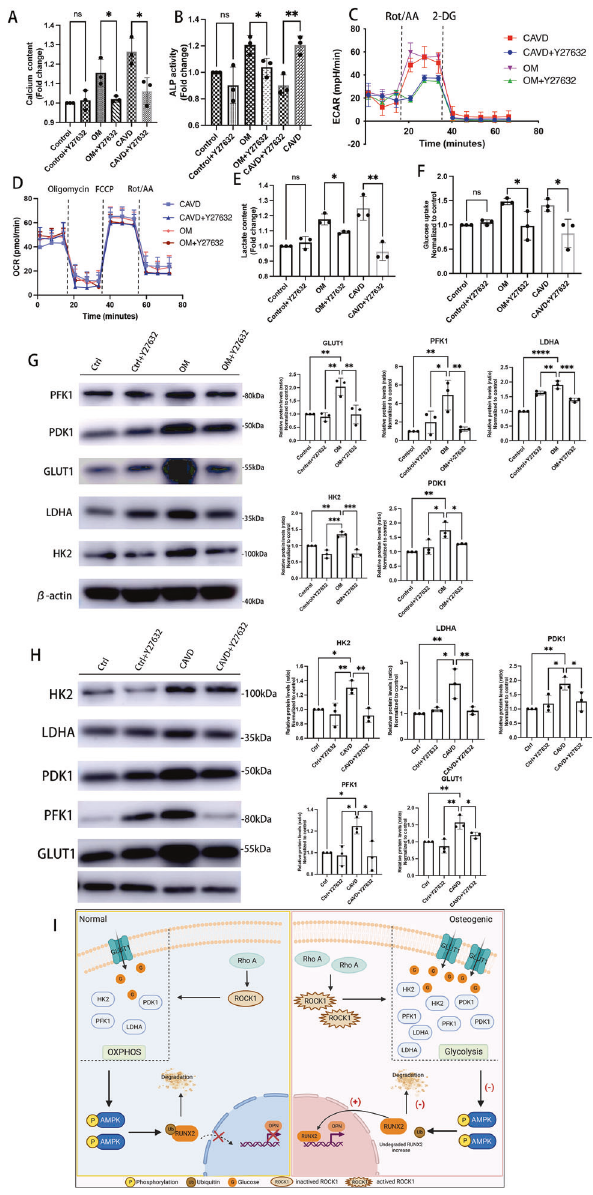
Fig. 8 Rho A/ROCK1 signaling positively regulate Warburg effect in osteogenic human VICs. A , B Calcium content and ALP activity was quanti fi ed in human aortic VICs from IP-OIM, non-CAVs and CAVs, treated with or without Y27632 (Unpaired two-tailed Student ’ s t -test). C , D Seahorse pro fi les for extracellular acidi fi cation rate (ECAR) of VICs from IP-OIM, non-CAVs and CAVs, cultured in